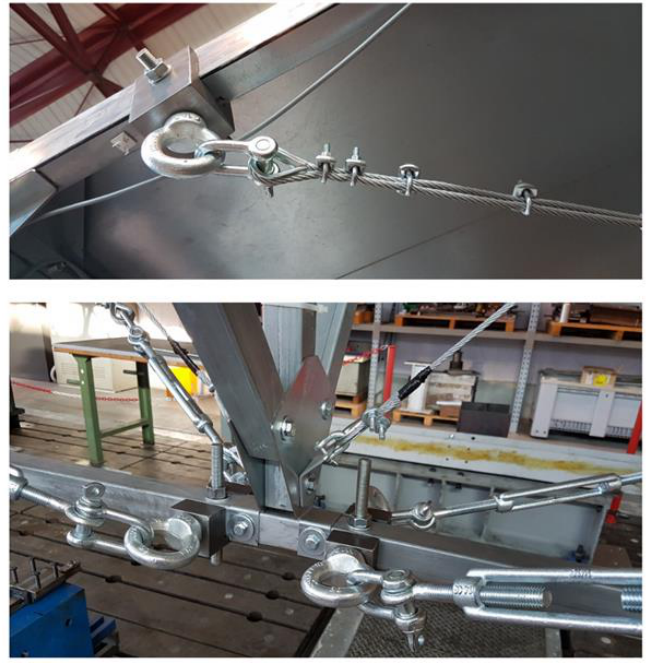
Figure 19. Detail of the connection of the gripping device with the transverse (top) and the back beam (bottom).